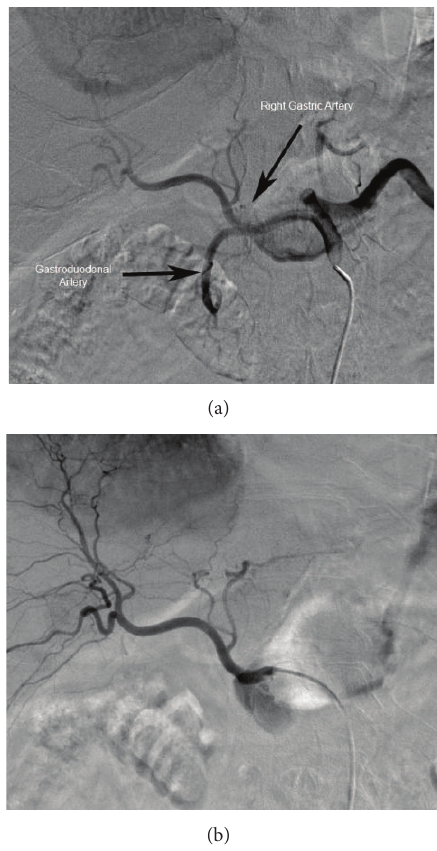
Figure 1: (a) Celiac angiogram demonstrates antegrade flow in the right gastric and gastroduodenal arteries. (b) Common hepatic angiogram with balloon inflation demonstrates absence of ante- grade flow in the right gastric and gastroduodenal